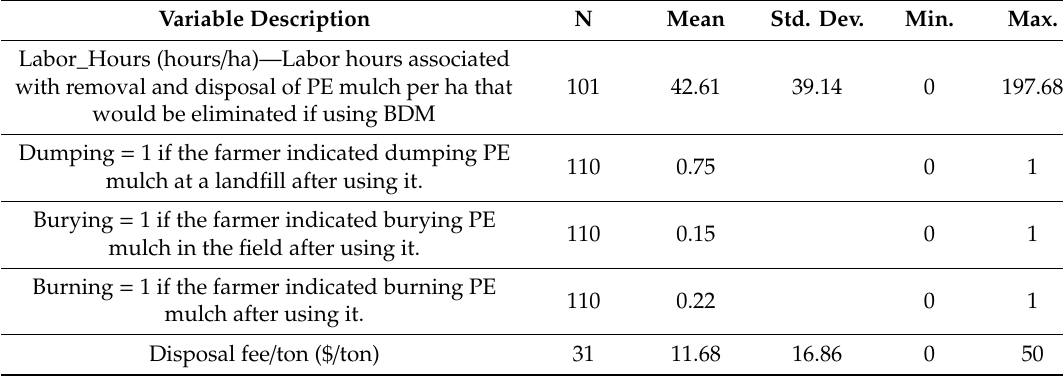
Table 3. Average removal and disposal labor hours, disposal practices, and disposal cost. Variable Description N Mean Std. Dev. Min.